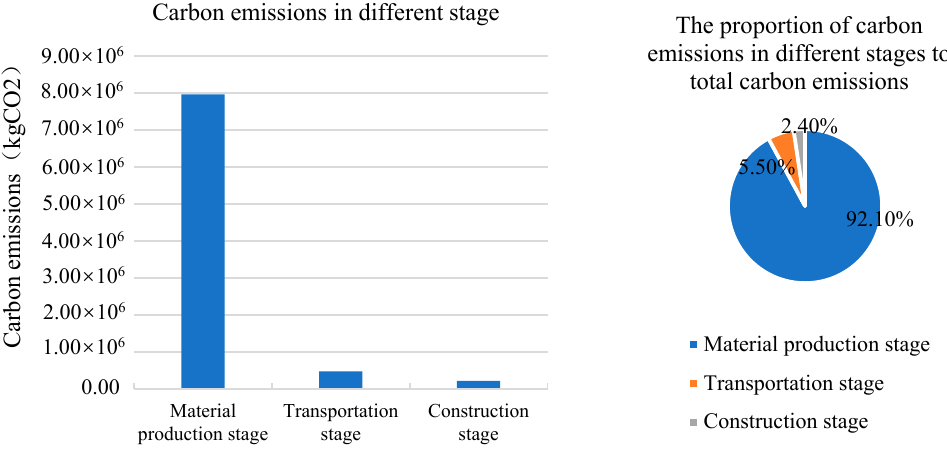
Figure 4. Comparison of carbon emissions in different bridge stages.